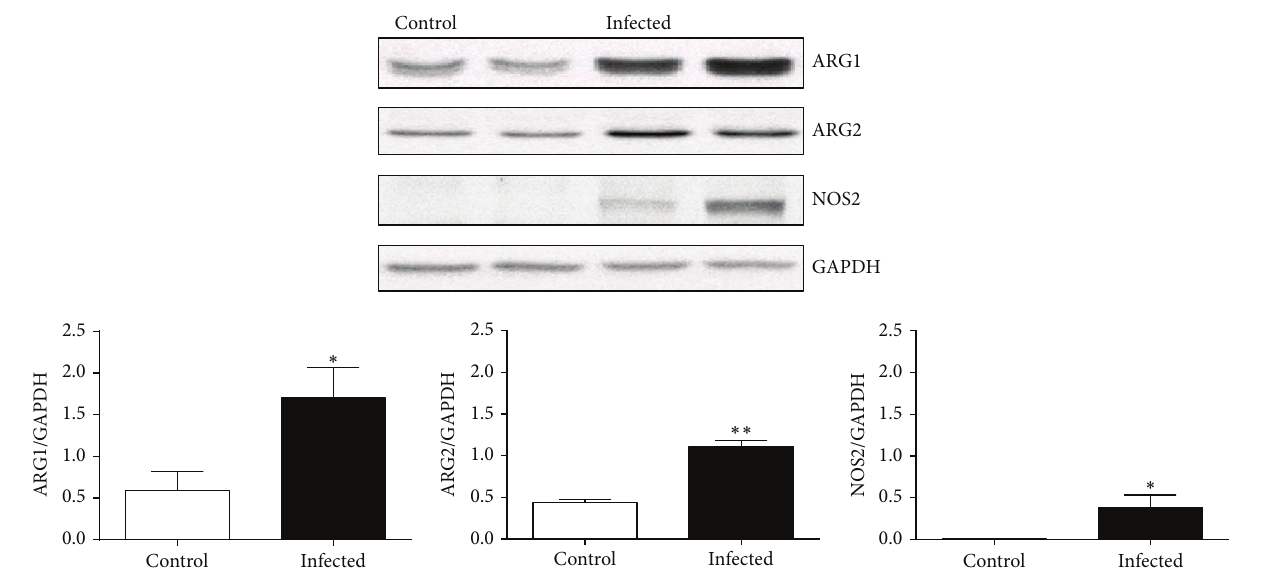
Figure 1: Expression of inducible nitric oxide synthase (NOS2) and the arginase isoform types I (ARG1) and II (ARG2) normalized to GAPDH, respectively, in lung of Pseudomonas aeruginosa infected mice and na¨ıve control ( 𝑛 = 6 per group). Infection resulted in a significant increase in protein expression of all three enzymes ( ∗ 𝑃 < 0.05 , ∗∗ 𝑃 < 0.0001 ).